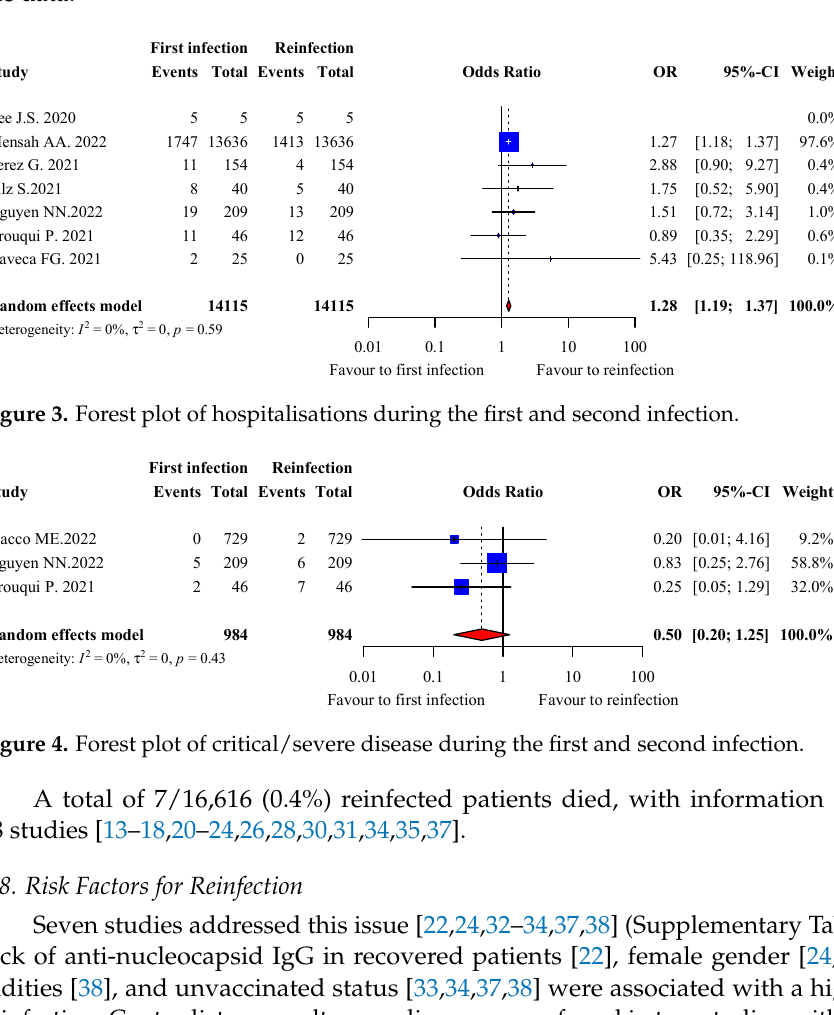
Figure 4. Forest plot of critical/severe disease during the first and second infection.